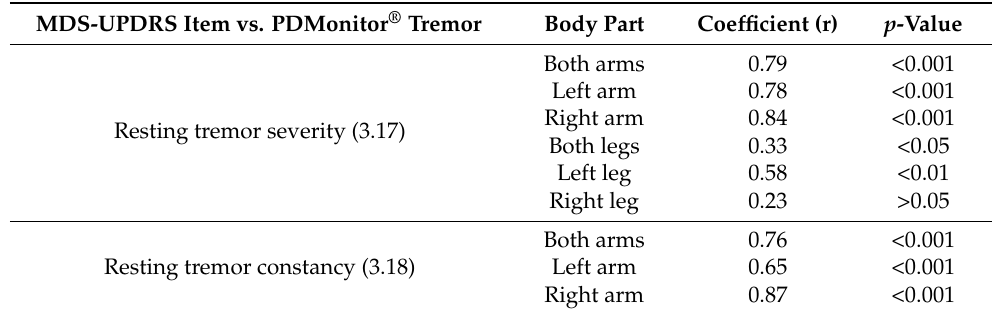
Table 5. The correlation of the MDS-UPDRS scores on resting tremor severity and constancy to the PDMonitor ® tremor using Pearson’s correlation.